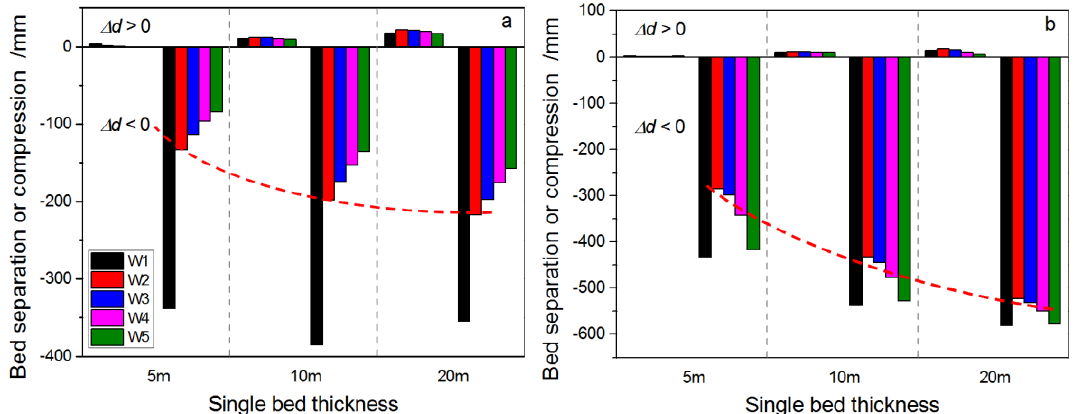
Figure 4. Extreme value statistics of bed separation and compression along various well trajectories after the ( a ) first panel is removed and then ( b ) twin panels are removed sequentially in cases of various SRLTs.